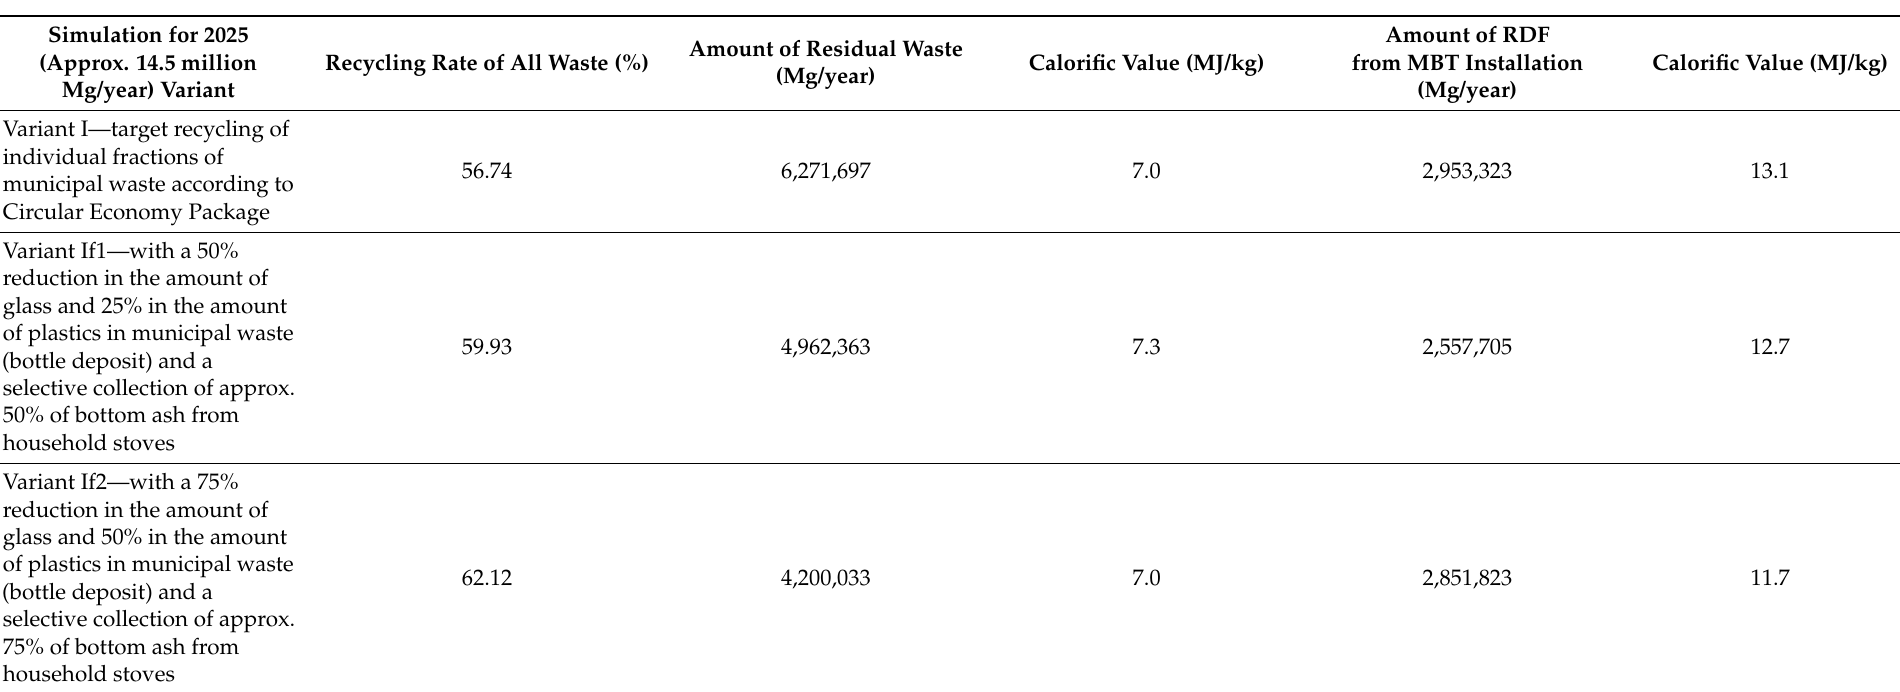
Table 15. The amount and calorific value of residual waste and RDF for various variants of the Circular Economy Package